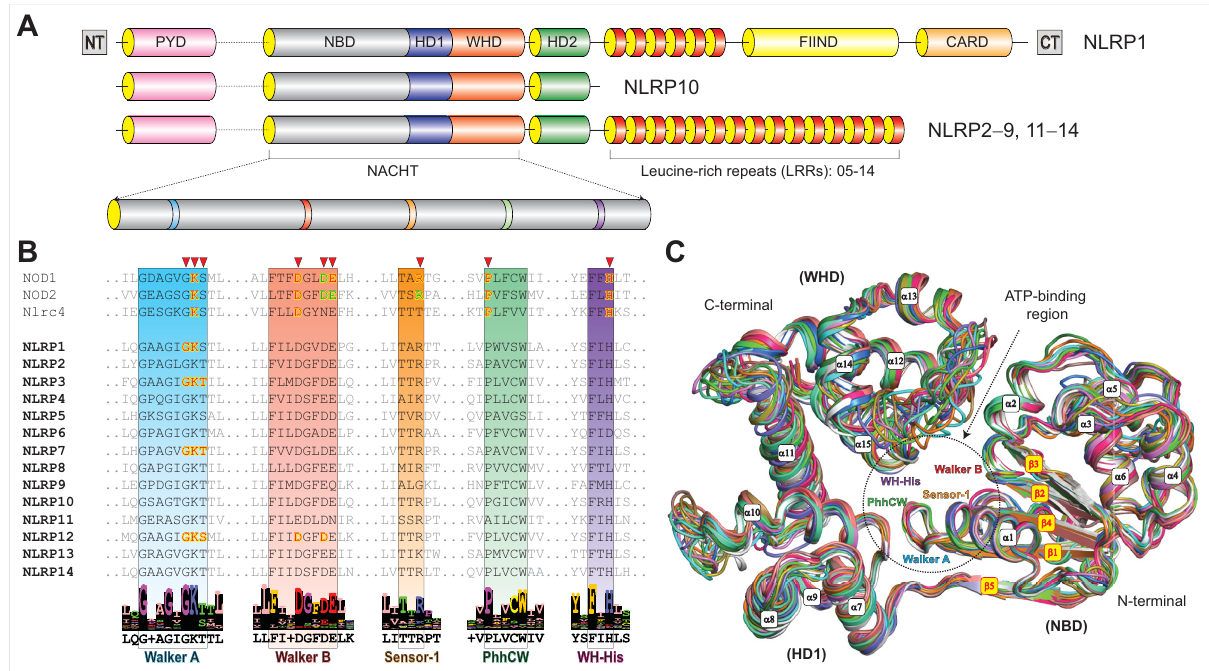
Fig 1. Domain organization, ATP-binding motifs and structural overview of NLRP NACHT 3D models. (A) NLRPs show tripartite domain architecture (PYD-NACHT-LRR) except NLRP1 (which possesses two additional C-terminal domains: FIIND and CARD) and NLRP10 (that lacks the LRRs). Magnifying view of NACHT domain illustrates key ATP-binding motifs. (B) The key ATP-binding motifs (from multiple sequence alignment) are boxed in different colors (Walker A: blue; Walker B: salmon; Sensor- 1: orange; PhhCW motif: green; WH-His: purple). The experimentally validated amino acids involved in ATP-binding are shown in red fonts and those not interacting are displayed in green font. (C) Structural overview of NLRP NACHT models based on Oc NOD2 crystal structure (5IRL [41]) (illustrated in different colored cartoons: NLRP1, white; NLRP2, deep salmon; NLRP3, marine; NLRP4, green; NLRP5, violet; NLRP6, orange; NLRP7, hot pink; NLRP8, slate; NLRP9, sand; NLRP10, cyan; NLRP11, dirty violet; NLRP12, forest; NLRP13, green-cyan; and NLRP14, olive) indicate the secondary structural elements ( α -helices and β -sheets, which are labeled in white and red fonts within red and yellow boxes, respectively). The ATP/ADP-binding region is displayed in black dotted circle along with the NTP-binding